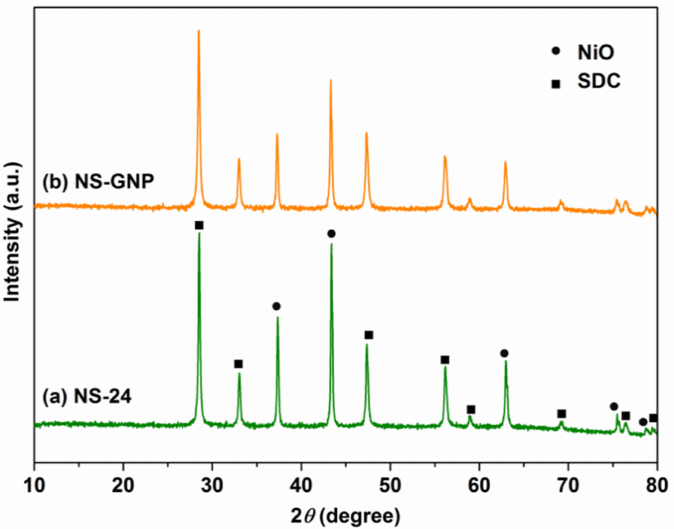
Figure 3. XRD patterns of ( a ) NS-24 and ( b ) NS-GNP composite anode powders. The TEM images at 5000 × magnification for NS-GNP and NS-24 composite anode powders are shown in Figure 4. The TEM micrograph shows a foam-like morphology with uniformly distributed macro-sized particles with NiO and SDC for NS-GNP (Figure